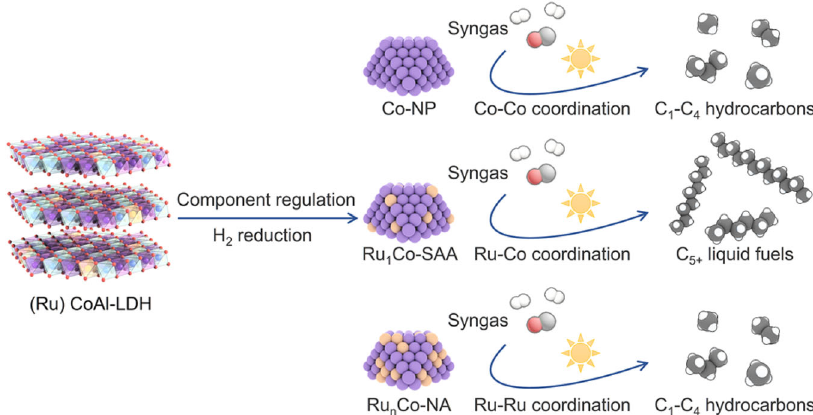
Fig. 1 | Schematic illustration of the fabrication of the catalysts and the main productsofCOphoto-hydrogenation. Theleftillustrationshowsthestructureof LDH precursors. The middle illustration shows nanostructures of active nano- particles in Co-NP, Ru 1 Co-SAA and Ru n Co-NA catalysts derived from LDHs. The